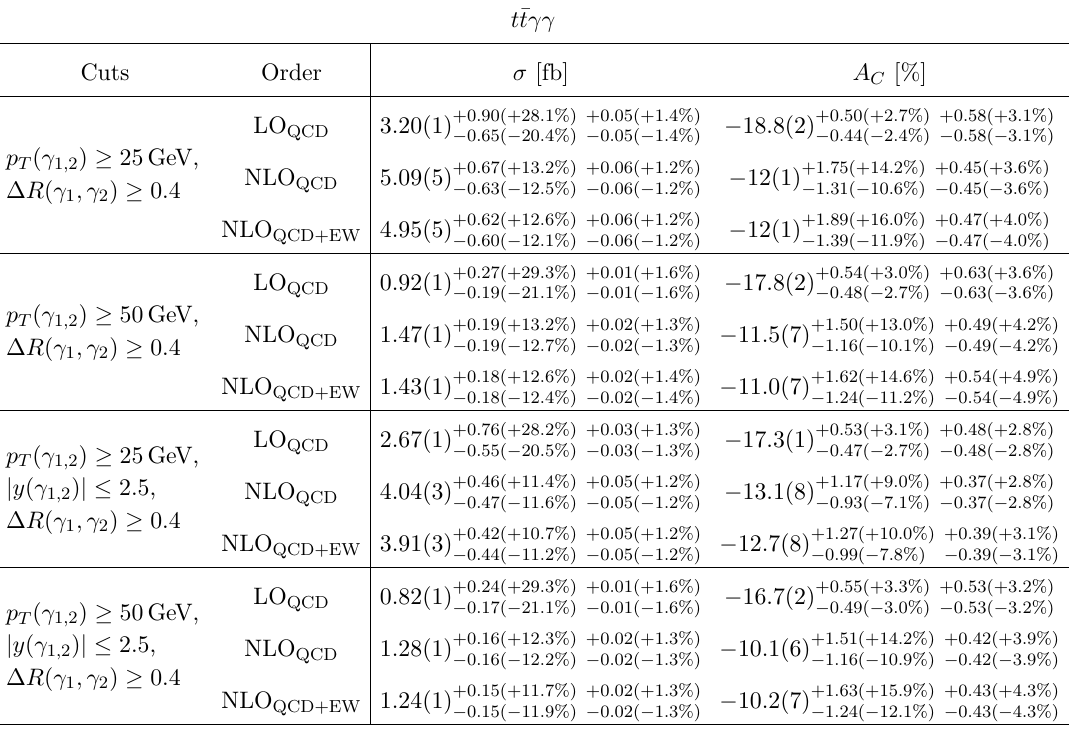
Table 3 . Cross sections and charge asymmetries for t ¯ tγγ production. The uncertainties are respec- tively the scale and the PDF ones in the form: ± absolute size ( ± relative size). The first number in parentheses after the central value is the absolute statistical